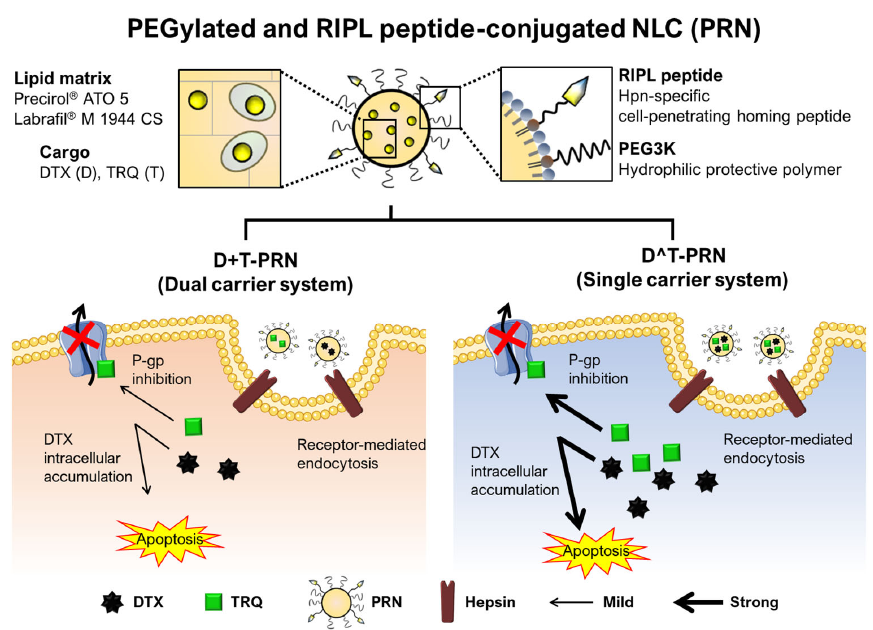
Figure 1. Schematic illustration of the co ‐ delivery system and the proposed cell apoptosis pathway induced by the docetaxel (DTX) ‐ and/or tariquidar (TRQ) ‐ loaded PEGylated (5 mol%) and RIPL peptide ‐ conjugated nanostructured lipid carrier (PRN). Hydrophobic cargos (DTX and TRQ) are loaded separately into different PRNs (dual ‐ carrier system) or simultaneously co ‐ loaded into a PRN (single ‐ carrier system). The lipid matrix of the PRN is composed of both solid lipid (Precirol ® ATO 5) and liquid oil (Labrafil ® M 1944 CS). The PRN surface is functionalized with a hepsin (Hpn) ‐ specific cell ‐ penetrating homing peptide (RIPL peptide) and a hydrophilic protective polymer (PEG3K). The PRN can recognize and selectively bind to overexpressed Hpn, which results in enhanced internalization via receptor ‐ mediated endocytosis. The PRN escapes from the endosomes and releases DTX and TRQ into the cytosol. Subsequently, TRQ inhibits the P ‐ glycoprotein efflux pump and thereby enhances the intracellular accumulation of DTX to induce cancer cell apoptosis.